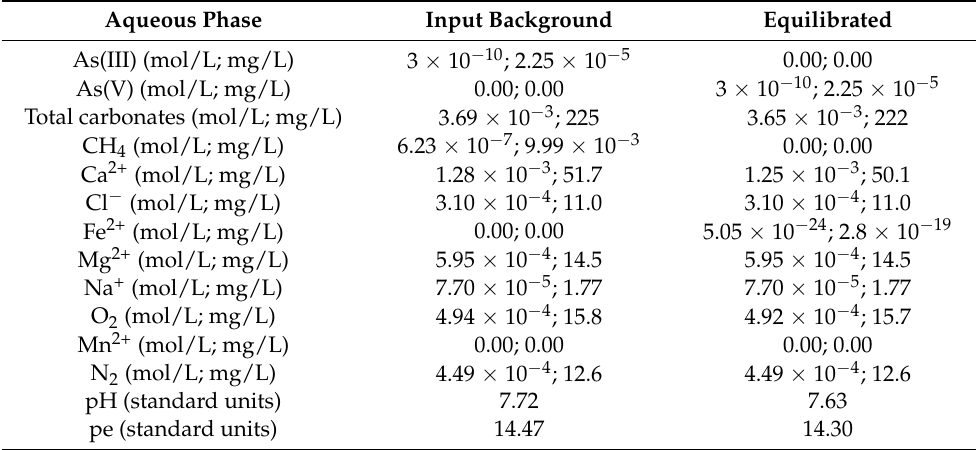
Table 2. Initial conditions and background concentrations of inorganic aqueous species. The second column shows average concentrations from an uncontaminated background well, 310e (see Figure 1), located upgradient; the third column shows PHREEQC-2 batch simulation results after equilibrating with calcite, Fe(OH) 3 (a), and MnO 2 and establishing charge balance. The equilibrated concentrations were used for constant concentration fluxes at the left and top model boundary. Arsenic was removed from the constant concentration flux boundaries because it was non-detectable (<1 µ g/L; <1.35 × 10 − 8 M). Aqueous Phase Input Background Equilibrated As(III) (mol/L; mg/L) 3 × 10 − 10 ; 2.25 × 10 − 5 0.00; 0.00 As(V) (mol/L; mg/L) 0.00;